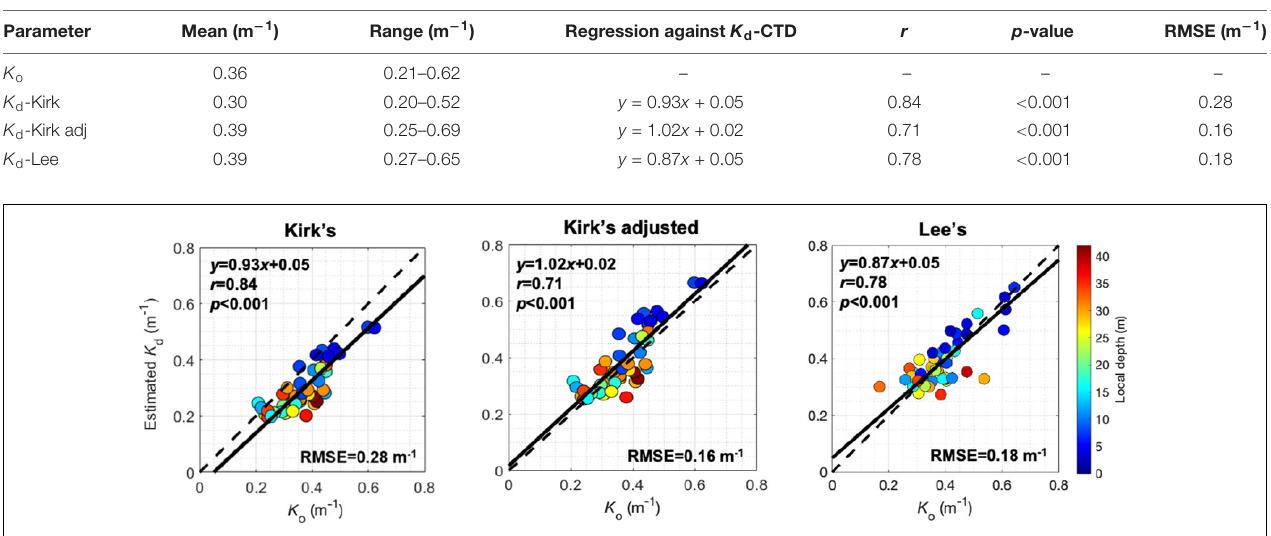
FIGURE 6 | Examples of E spectra over depth measured in situ with the free-falling Satlantic optical profiler (a) and estimated with Kirk’s (b) and Lee’s (c) methods. Examples of spectrally resolved K estimated from Satlantic measurements (d) and obtained with Kirk’s (e) and Lee’s (f) methods. All the examples displayed in this figure are from the same visited station on Jun. 13th, 2019. Colors in the top panels (a–c) represent different sampling depths, with the top lines indicating close-to-the-surface measurements and the bottom lines indicating measurements performed close to the bottom. TABLE 1 | Mean, range, and information regarding the correlation (regression, r , p -value and RMSE) between the referred parameter and K o for K o , K d -Kirk, K d -Kirk adjusted ( K d -Kirk adj) and K d -Lee.